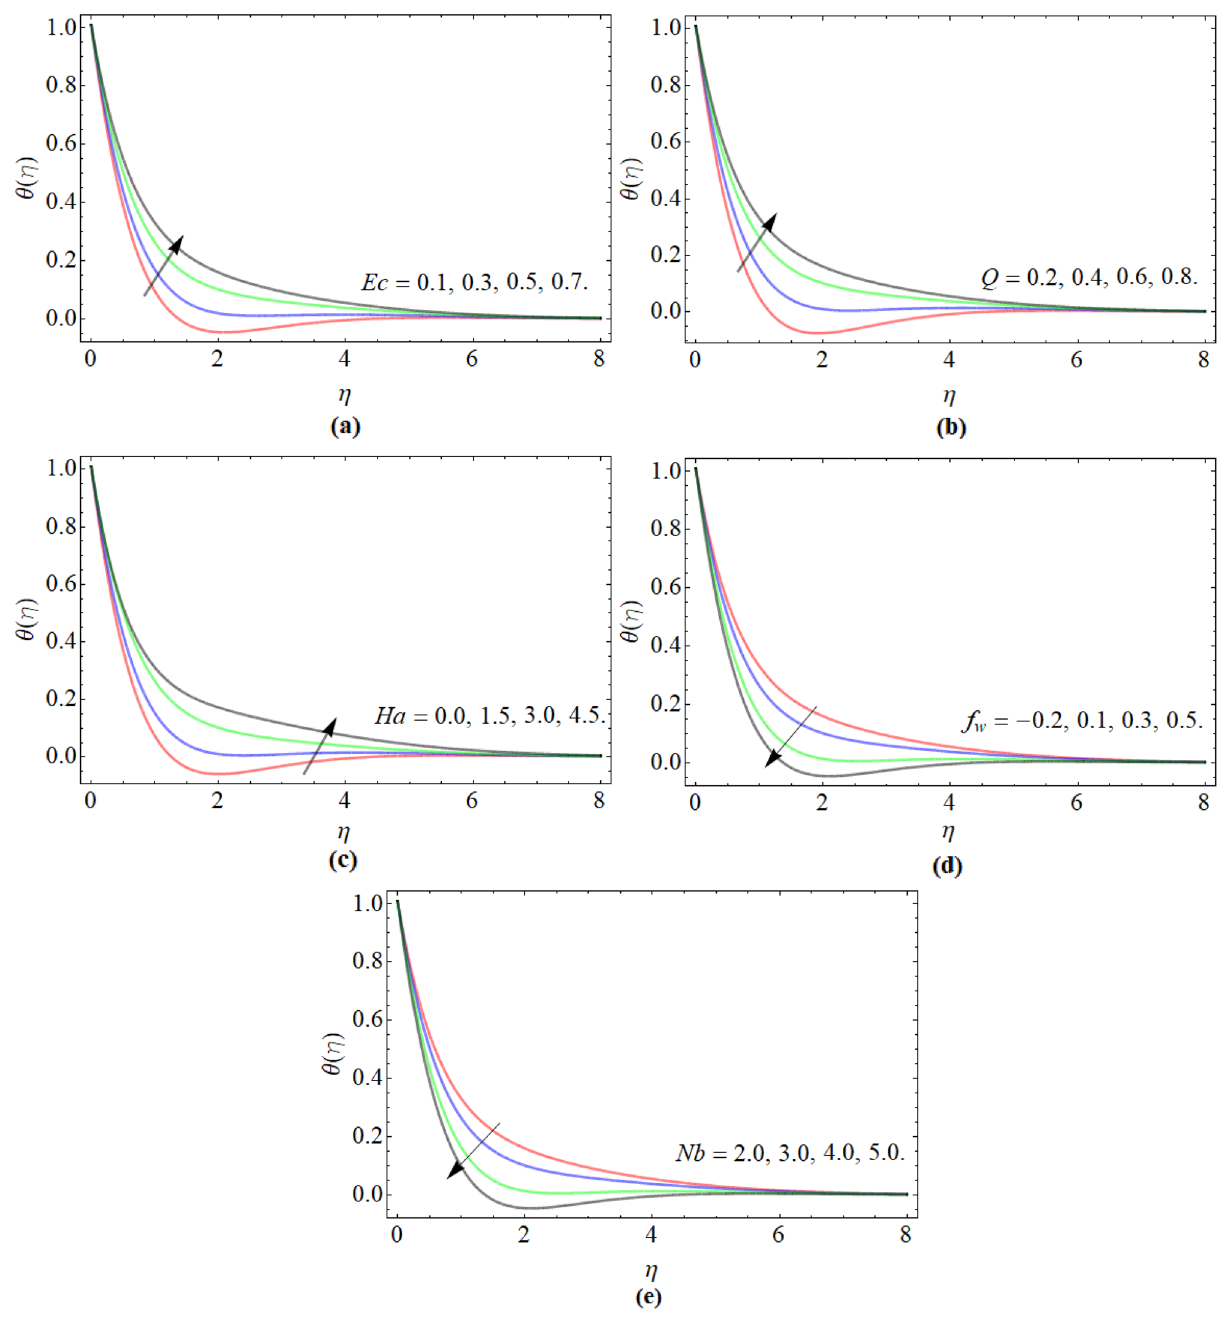
Figure 3. The nature of energy transition θ(η) profile versus ( a ) Eckert number Ec , ( b ) heat absorption/ generation Q , ( c ) Hartmann number Ha , ( d ) suction/injection f w , ( e ) Brownian motion Nb